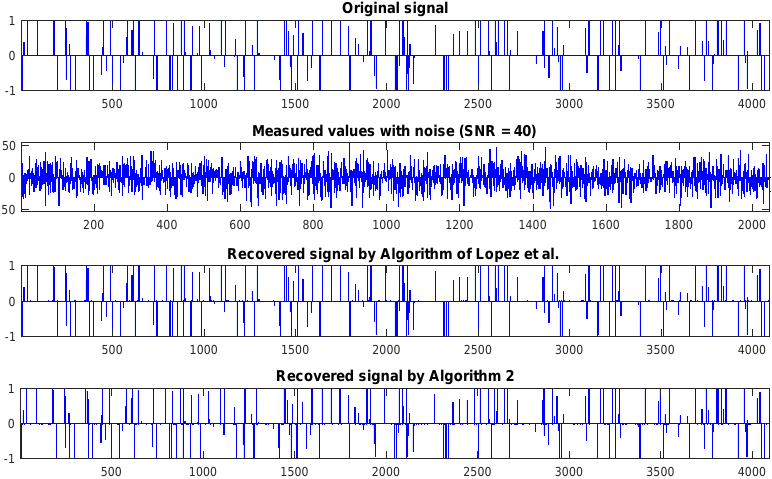
Figure 4. From top to bottom: original signal, observation data, recovered signal by Algorithms (12) of López et al. [10] and Algorithm